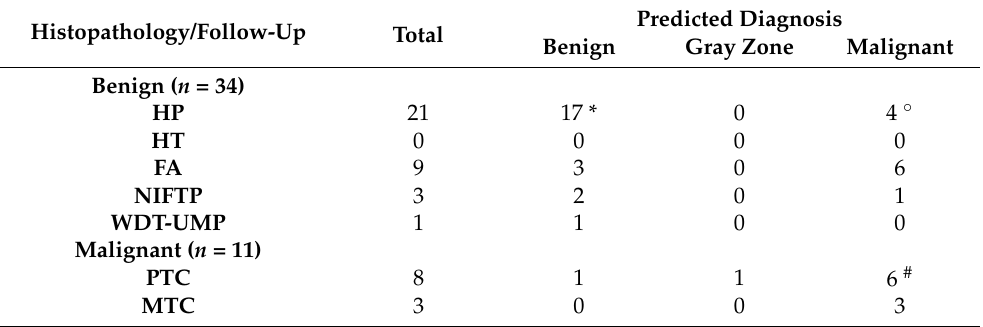
Table 2. Predicted diagnosis based on the three-level diagnostic classification strategy in the pixel-by- pixel analysis of the 45 nodules with indeterminate cytology and adequate cellularity according to